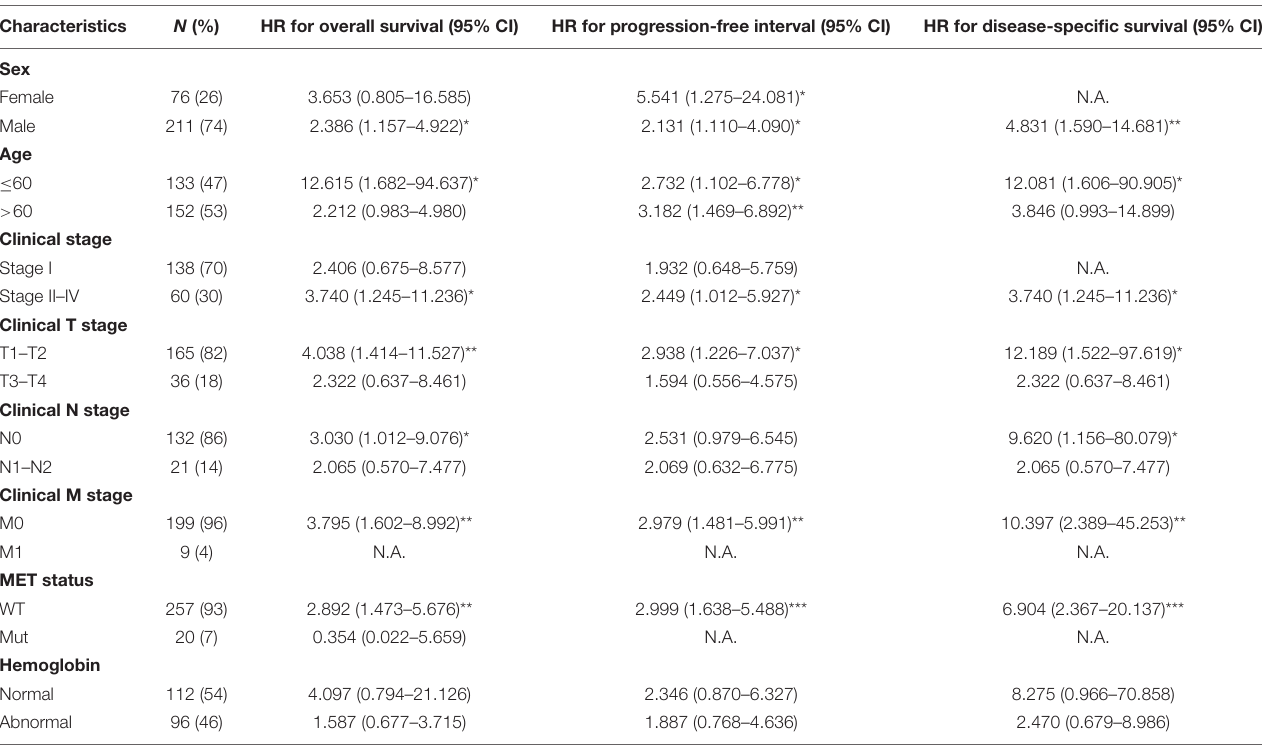
TABLE 4 | Prognostic performance of TICRR on clinical outcomes in PRCC patient subgroups by Cox regression analysis.